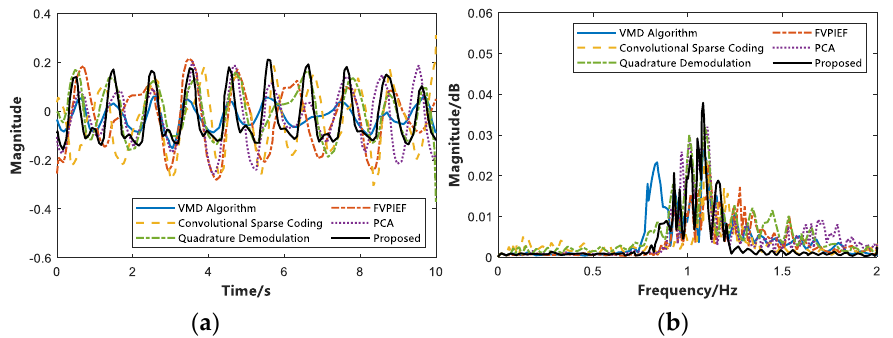
Figure 14. Time domain and frequency domain of heartbeat estimation using different algorithms. ( a ) Time domain diagram of heartbeat estimation. ( b ) Frequency domain diagram of heartbeat estimation.